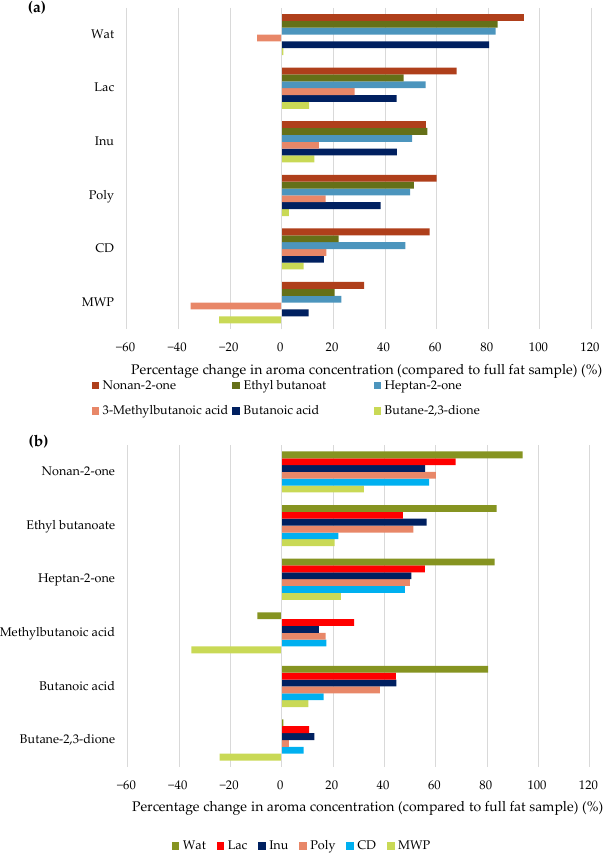
Figure 3. Percentage change in the headspace aroma concentration of all reduced-fat samples com- pared to the full-fat sample, sorted by emulsion formulation ( a ) and aroma compound ( b ). Considering the aroma release of all aroma compounds for each formulation, the big- gest changes in aroma release compared to the full-fat sample were found for the Wat sample. The smallest changes were found for the MWP and CD samples, indicating that the aroma profiles were most similar to the full-fat sample. In-between the Wat and the MWP/CD samples, the samples with Lac, Inu, and Poly showed a very similar aroma pro- file, indicating a similar influence on aroma release. Minor changes compared to the full- fat samples could mean no or little effect of the fat reduction and the use of fat replacers on the aroma release or similar aroma interaction capacities of the fat and the fat replacers. To get an indication of the effect on the aroma release, we can consider the differences between the full-fat and the Wat sample, in which we observed no significant changes in the aroma release of butane-2,3-dione and 3-methylbutanoic acid. Both aroma compounds